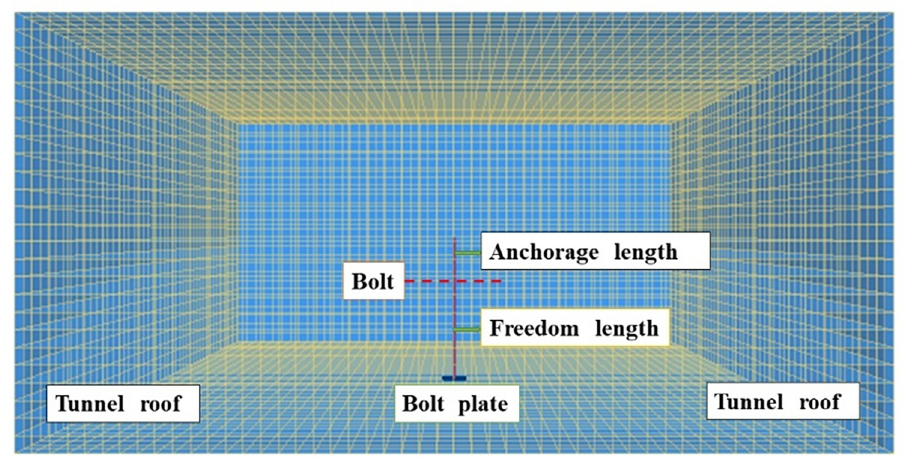
Fig 1. Bolt supporting model.